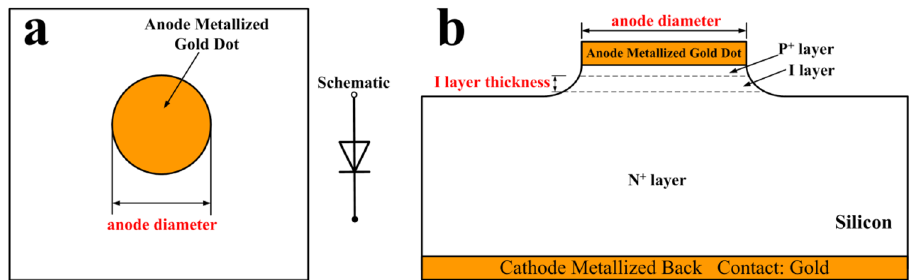
Figure 2. Structure of the model CLA series PIN diode. ( a ) Top view ( b ) Side